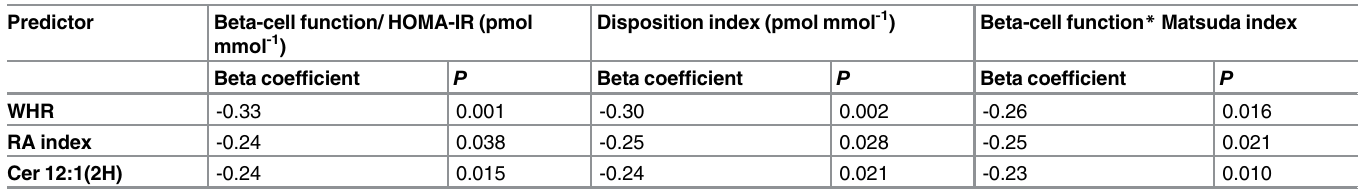
Summary of strongest predictors of beta-cell function using linear regression analysis. WHR, waist-to-hip ratio; HDL, high density lipoprotein cholesterol; RA index, resistin-to-adiponectin ratio; cer, ceramide. Data are presented as beta coef fi cient and P-value according to beta-cell function/HOMA-IR; Homeostatic Model Assessment of Insulin Resistance and DI; Disposition index; beta-cell function (glucose in mg dl -1 , insulin in μ IU ml -1 ) adjusted for the Matsuda index; P-value determined using backward linear regression analysis. Signi fi cance level = P < 0.05. Demographic and Anthropometric variables included